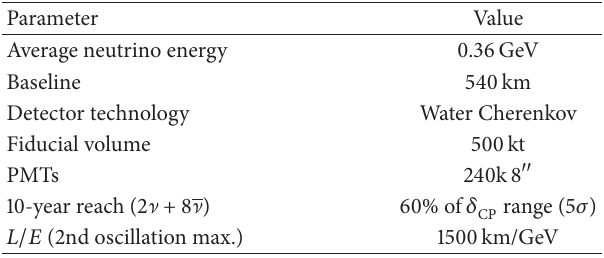
Table 1: Main parameters of the ESSnuSB neutrino facility.